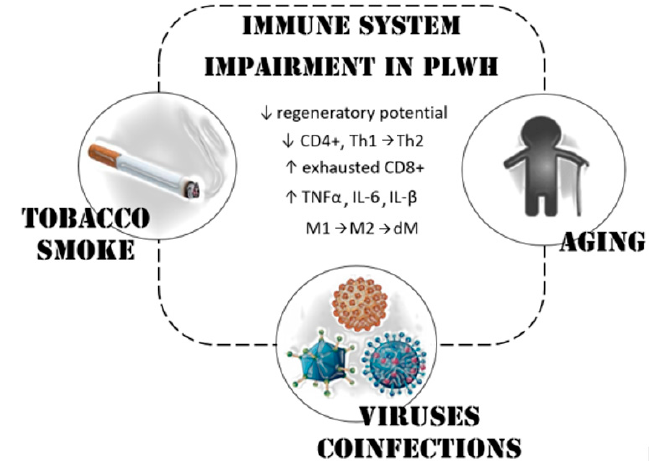
Figure 1. Pathogenesis of LC in people living with HIV (PLWH). Immune system evasion represents the main risk factor for cancer in HIV-positive patients. PLWH constitutively have a strong